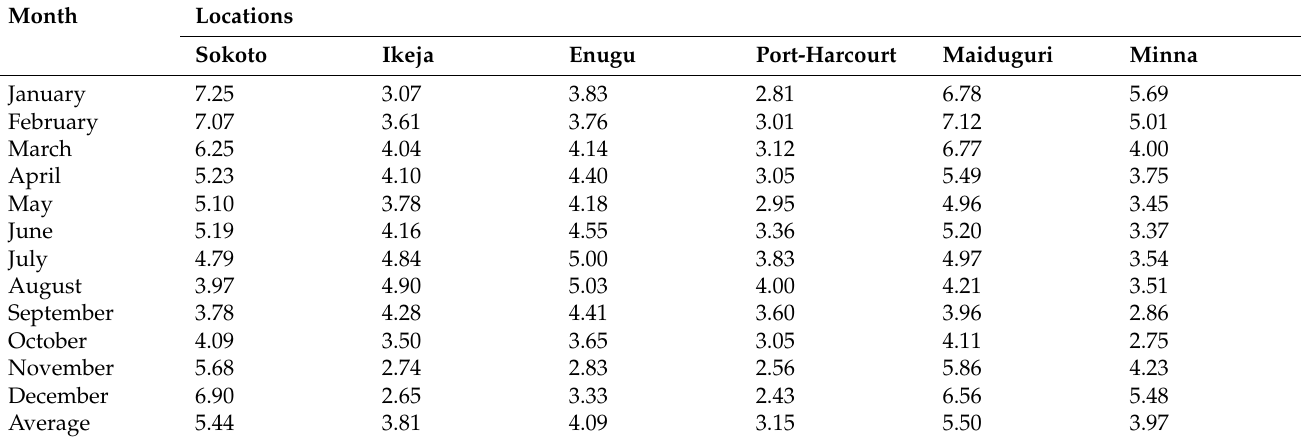
Table 5. Wind speed data of the case study sites for EVCS (m/s) [40].